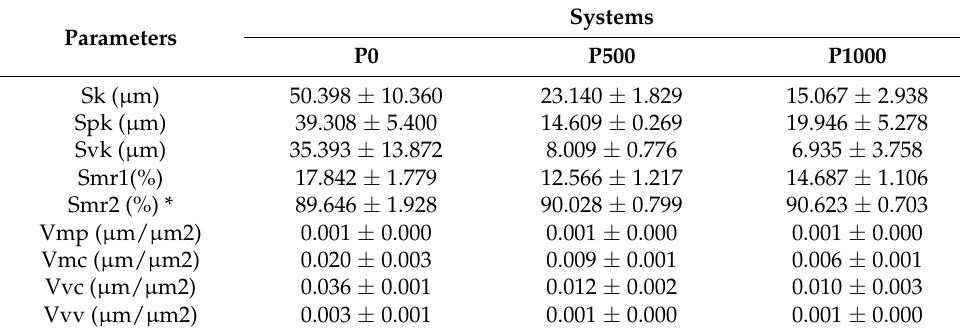
Table 2. Sk and volume parameters of the particles surface.